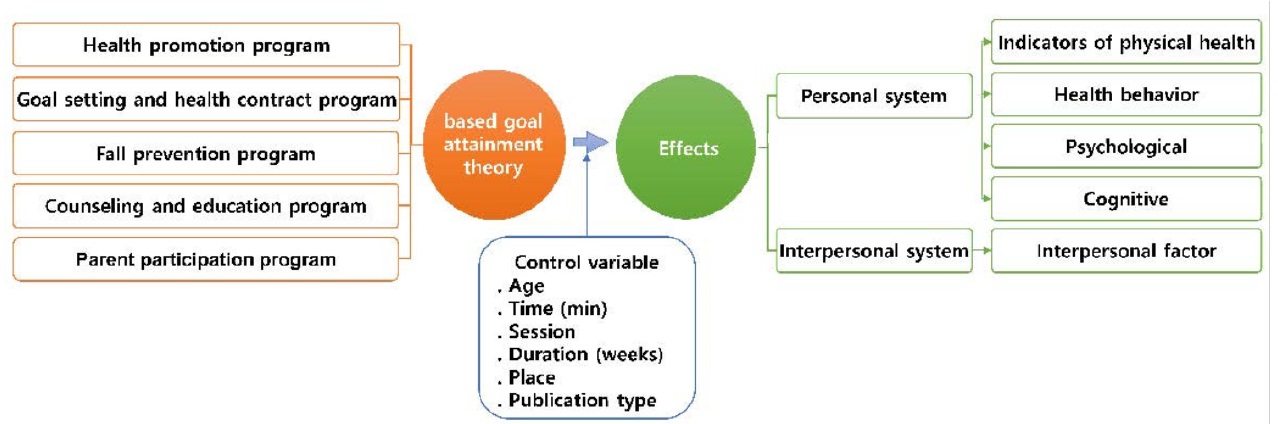
Figure 1. Research